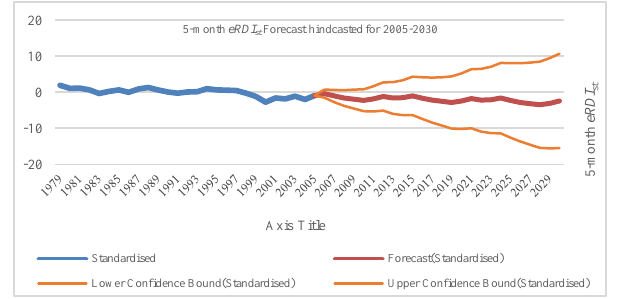
Figure 10: 5-month eRDIst future